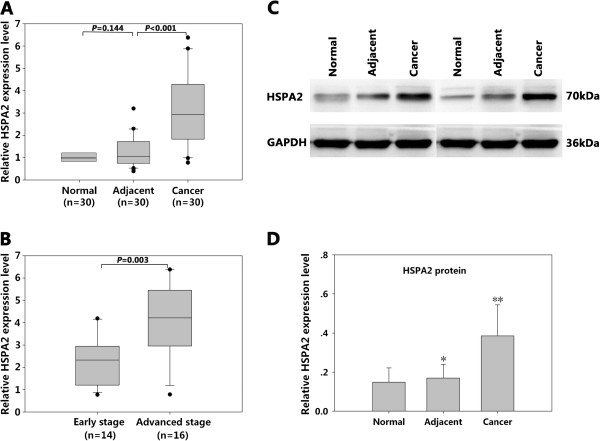
Comparison of HSPA2 mRNA and protein levels in ESCC samples, adjacent non-cancerous tissues and normal tissues by qRT-PCR and western blotting. (A) Relative HSPA2 mRNA expression levels in different tissues: cancer, 30 paired ESCC samples; adjacent, adjacent non-cancerous tissues; normal, normal esophageal tissues. (B) Relative HSPA2 mRNA expression levels in ESCC tissues at different stages: early and advanced. (C) Representative western blotting analysis of HSPA2 expression in all specimens. (D) Relative HSPA2 protein expression levels in different tissues. *P >0.05, compared with normal tissues; **P <0.05, compared with normal tissues and adjacent non-cancerous tissues. The relative HSPA2 protein expression level in ESCC tissues is about 2.67 times of that in normal esophageal tissues, and 2.35 times of that in adjacent non-cancerous tissues. Boxes represent the medians and interquartile ranges of the normalized threshold values. ESCC, esophageal squamous cell carcinoma; qRT-PCR, quantitative RT-PCR.